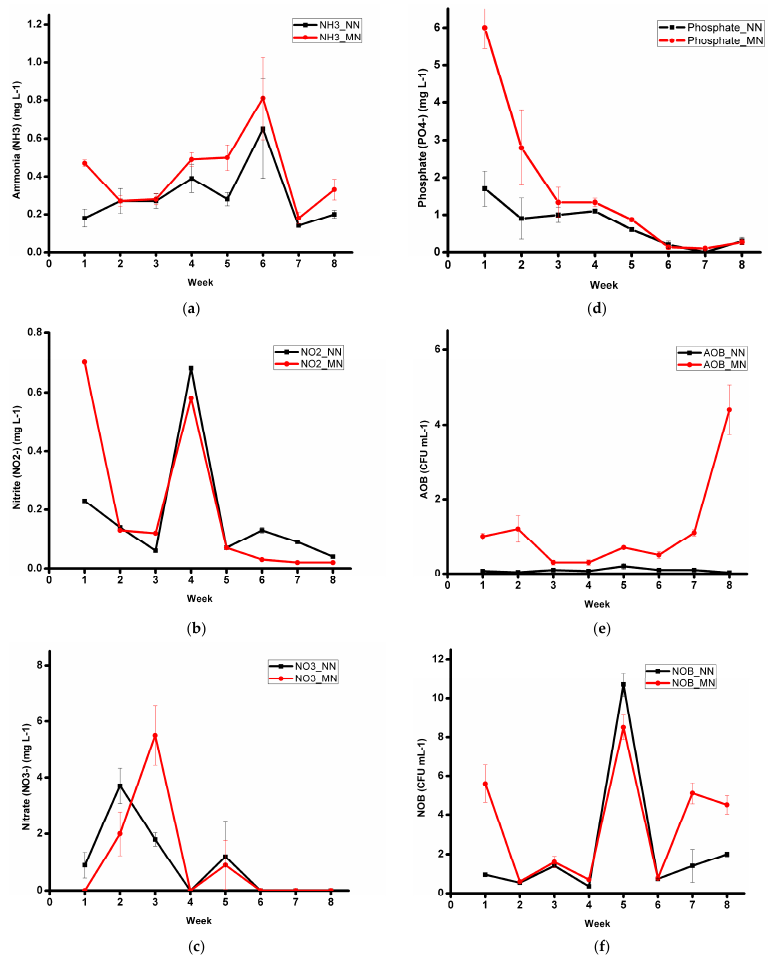
Figure 2. Weekly values for ( a ) ammonia, ( b ) nitrite, ( c ) nitrate, ( d ) phosphate, ( e ) AOB, ( f ) NOB (n =